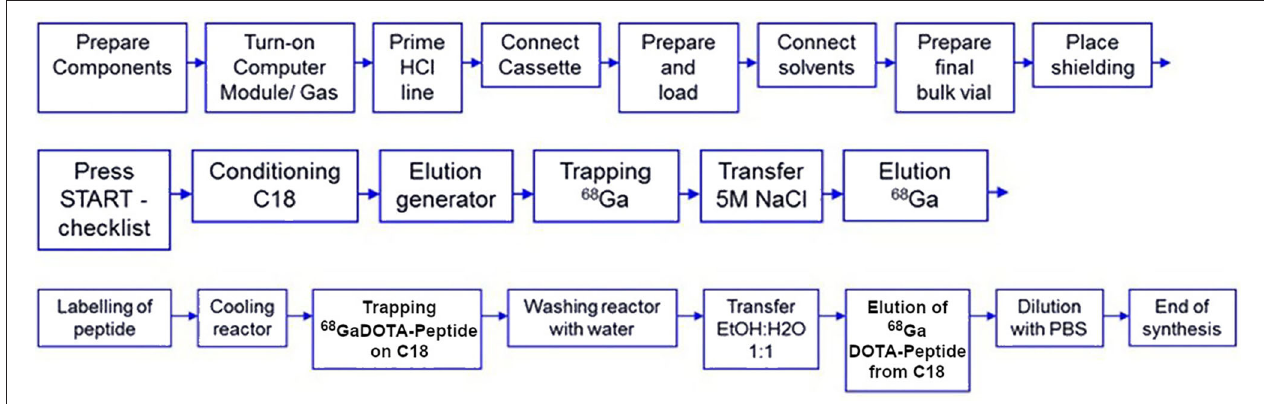
FIGURE 3 | Typical automated procedure for 68 Ga labeling of a DOTA peptide [adapted from (106)].